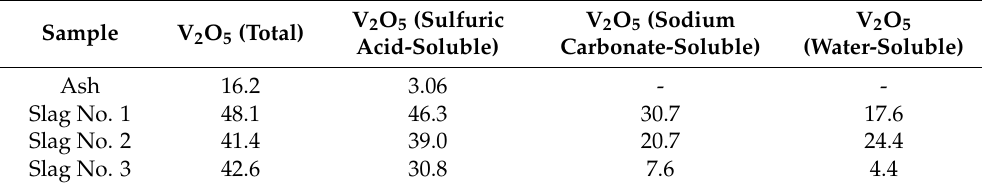
Table 5. Content of soluble forms of vanadium in slag samples, %wt.